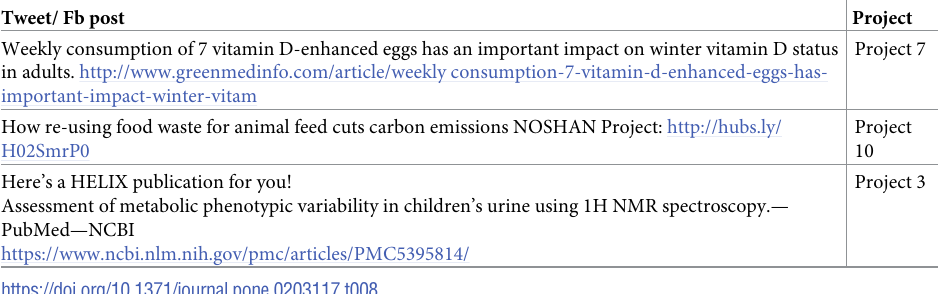
Table 8. Examples of tweets and Facebook posts with quantitative evidence of social impact. Tweet/ Fb